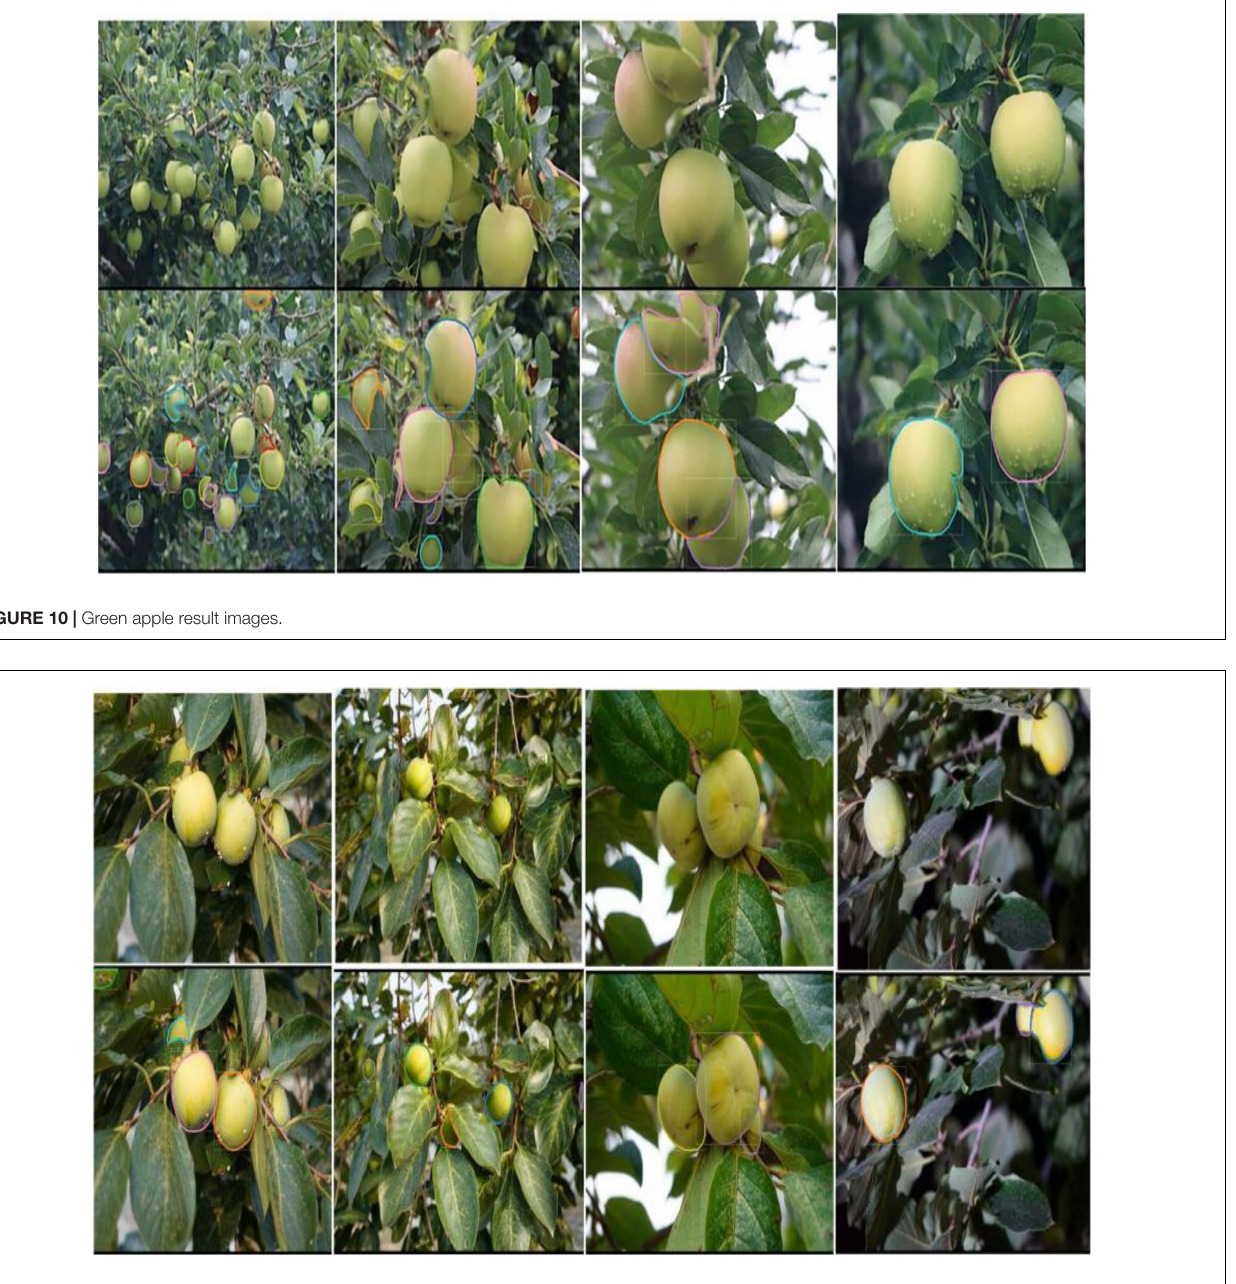
FIGURE 11 | Green persimmon result